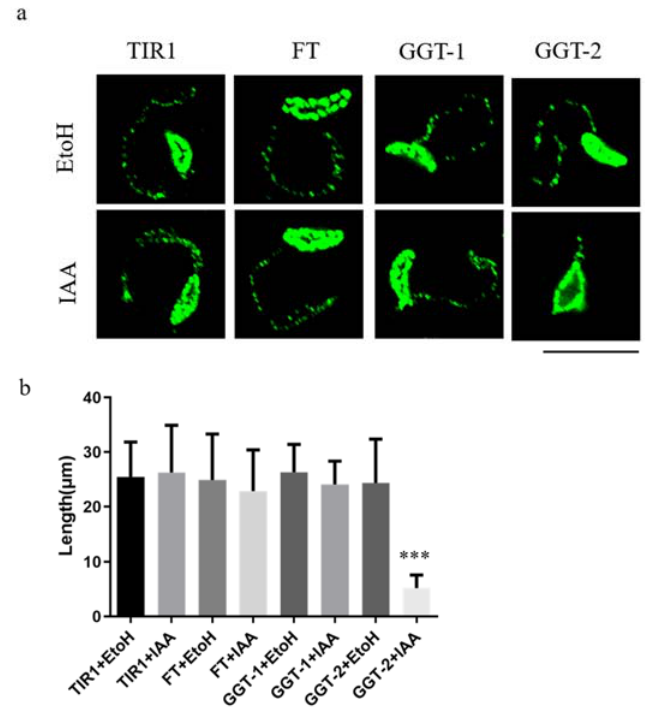
Figure 5. Degradation of GGT-2 inhibited the gliding motility of parasites. ( a ) The observation of moving tracts after TIR1/FT/GGT-1/GGT-2 was treated with IAA or EtoH for 24 h. IFA was performed when parasites were treated with 10mM deoxycholate for 20 min and a mouse anti- Toxoplamsa SAG1 monoclonal antibody was used as the primary antibody (green). ( b ) At least 20 moving tracts lengths of parasites were quantified in this assay. The data were presented as the means ± SEM with triplicate experiments ( *** p < 0.001). Scare bar: 10 µ